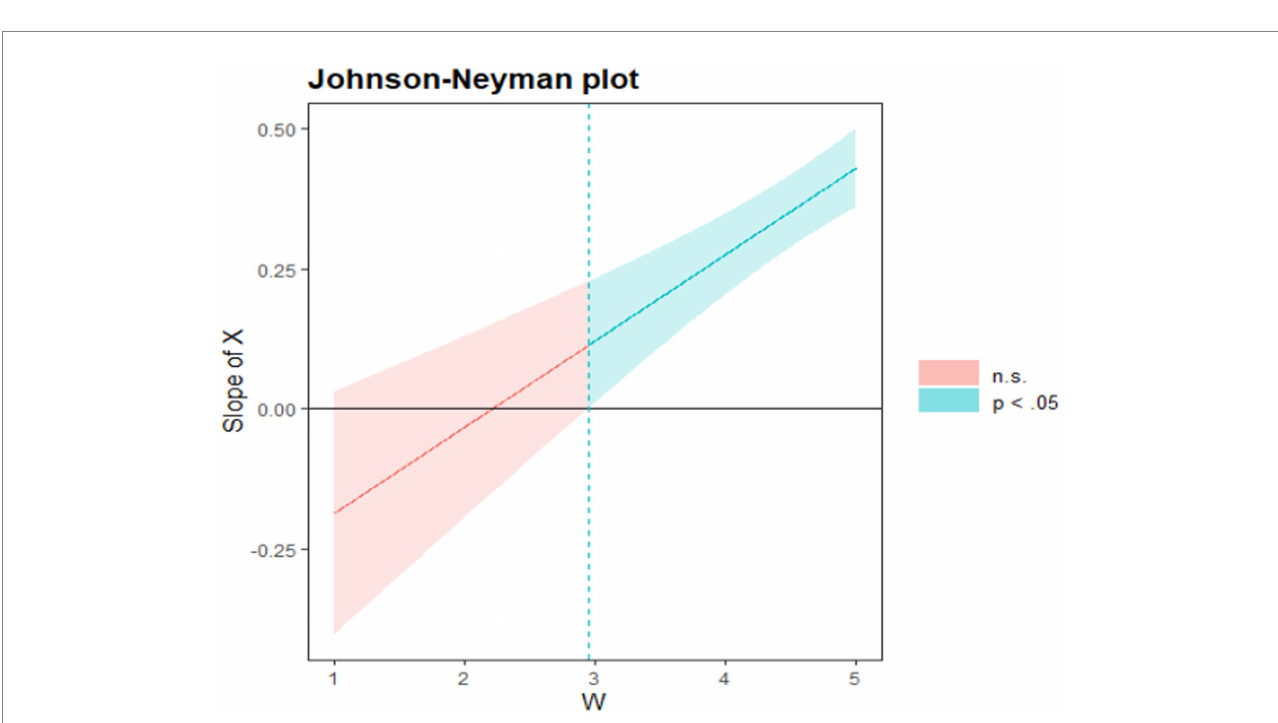
FIGURE 5 The moderating role of teacher support between school climate and learning adaptability. X is the dependent variable school climate; W is the moderating variable teacher